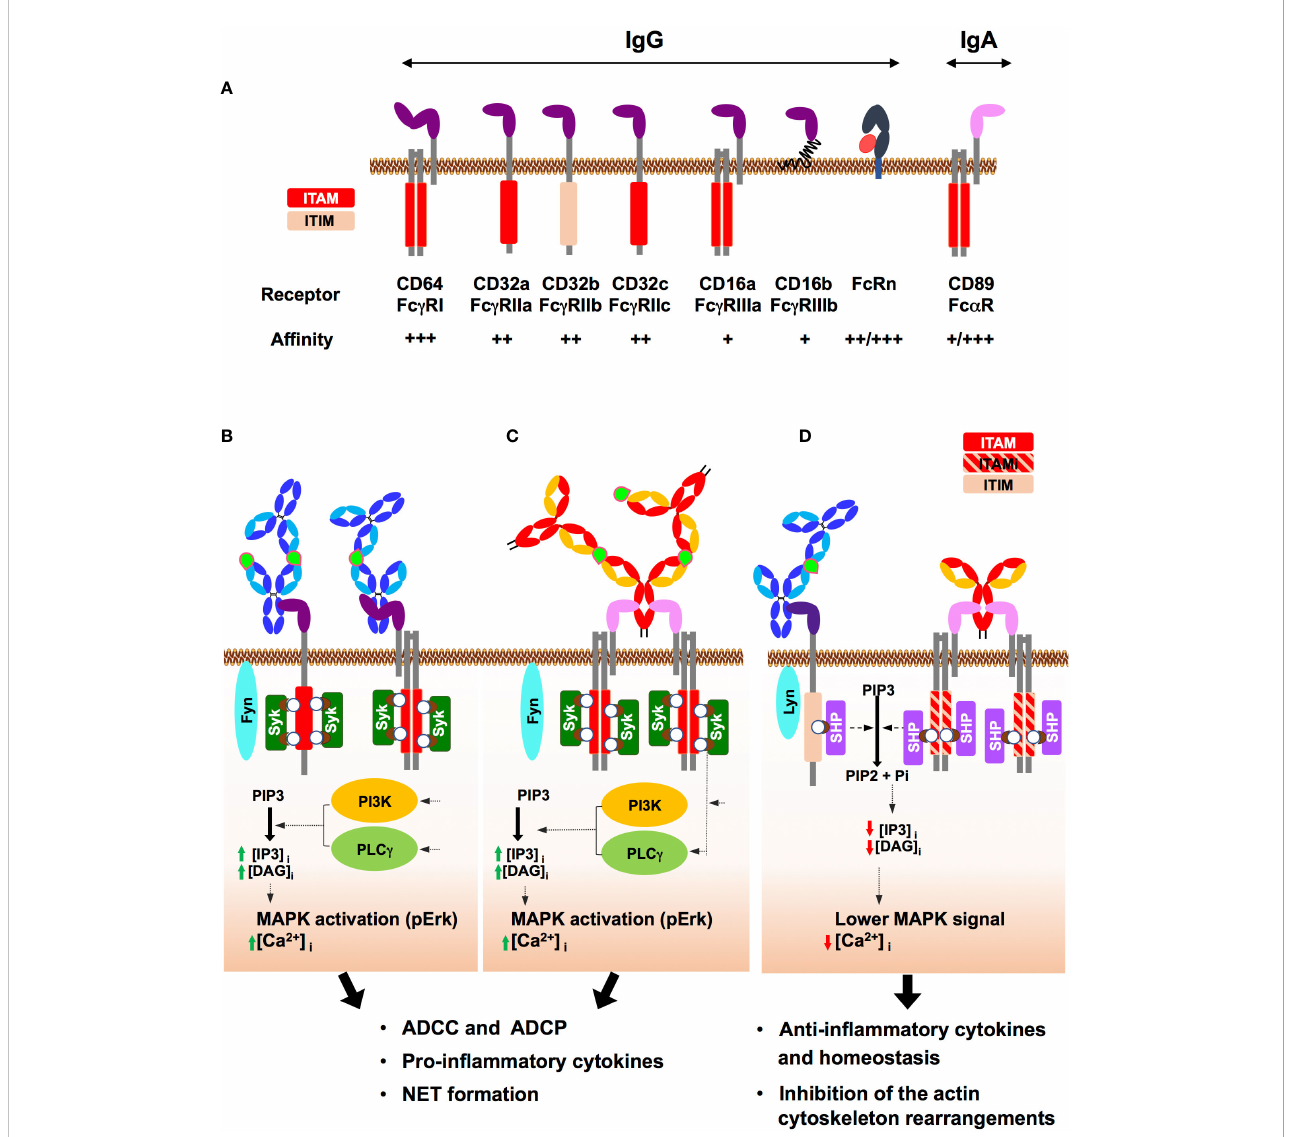
FIGURE 2 Human IgG and IgA Fc receptors (FcRs) and their mode of action. (A) Major IgG and IgA FcRs: IgG and IgA FcRs are represented at the cell membrane, associated where indicated with the adaptor protein FcR g . The respective af fi nities for IgG from + to +++ are indicated. For FcRn and Fc a RI/CD89, ++/+ ++ and +/+++ refer to the af fi nity level of antigen-free/antigen-bound antibodies. The activation (ITAM) and inhibition (ITIM) motifs of tyrosine-based immunoreceptors are shown in red and light pink, respectively. The neonatal Fc receptor (FcRn), a non-classical MHC class I only capable of interacting with IgG, is shown associated with its b 2-microtubulin chain (red). (B) ITAM-induced activation upon Fc g R binding by IgG-IC: IgG binding in the immune complex (IgG-IC) (antigen in light green) to Fc g RI/CD64 or Fc g RIIa/CD32a results in FcR clustering that triggers the Src kinase Fyn. In turn,